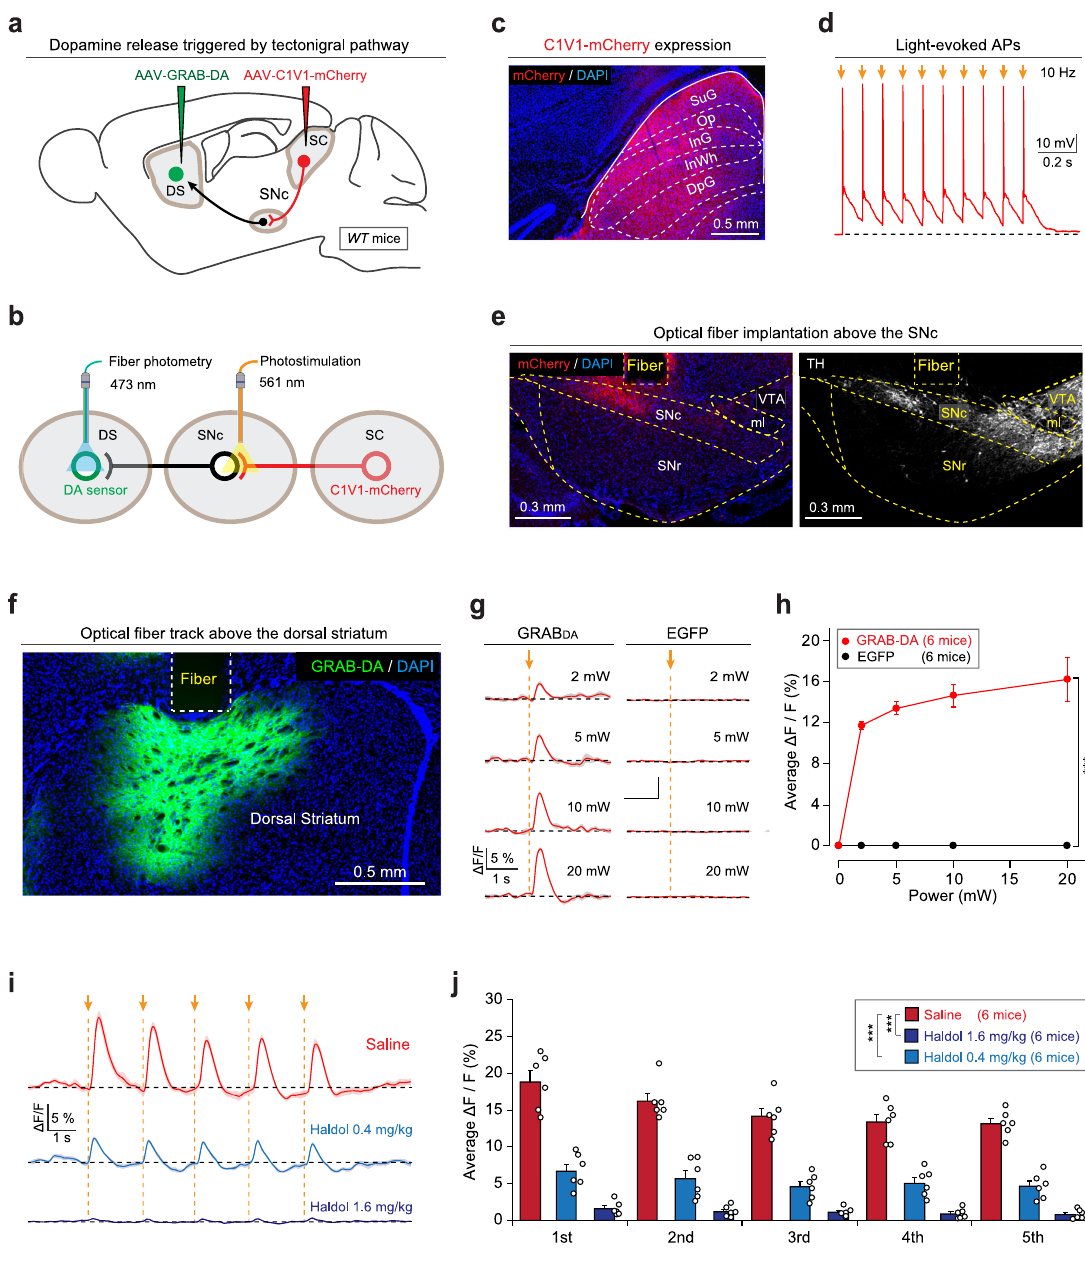
Fig. 3 Activation of the SC – SNc pathway triggers dopamine release in the dorsal striatum. a Schematic diagram showing injections of AAV-hSyn-C1V1- mCherry in the SC and AAV-hSyn-GRAB-DA in the dorsal striatum (DS) of WT mice. b Schematic diagram showing implantation of optical fi bers above the SNc and DS to apply photostimulation and fi ber photometry recording, respectively. c An example coronal section with C1V1-mCherry expression in the SC. This experiment was repeated independently in fi ve mice with similar results. d In acute SC slices, light pulses (2 ms, 561 nm, 10 Hz, 10 pulses) illuminating on C1V1-mCherry + SC neurons reliably triggered action potential fi ring. e An example coronal section of ventral midbrain showing an optical- fi ber track above the C1V1-mCherry + axon terminals in the SNc (left), the boundary of which was determined according to the immuno fl uorescence of TH (right). This experiment was repeated independently in six mice with similar results. f An example coronal section with an optical- fi ber track above the